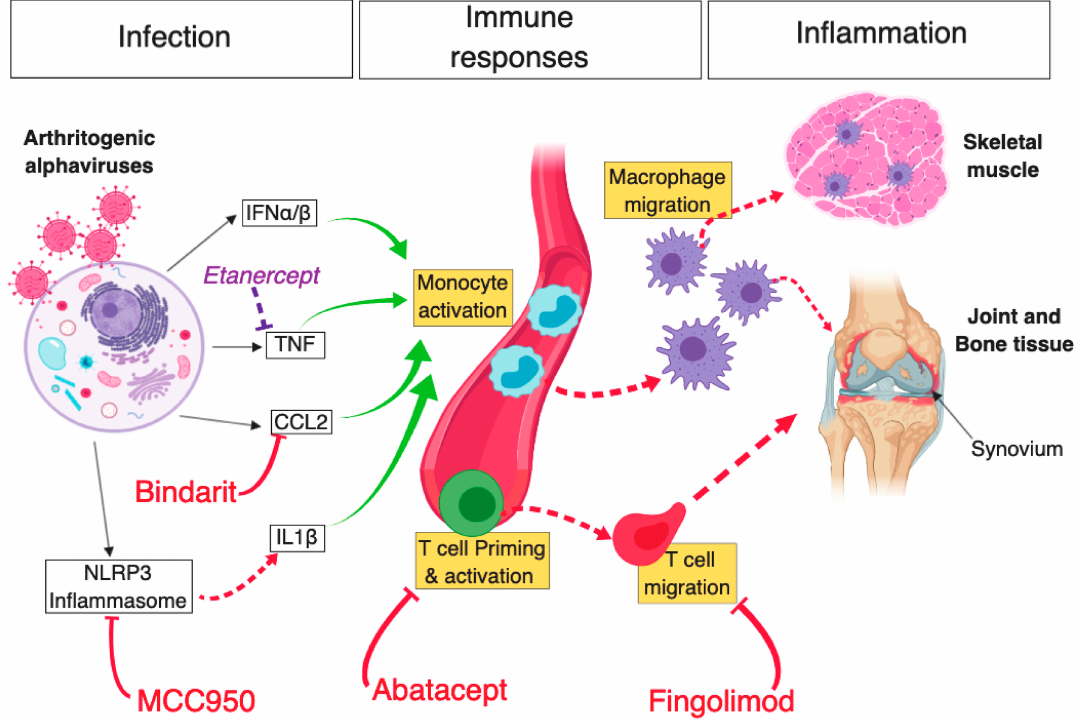
Figure 1. Schematic diagram of key mechanisms of arthritogenic alphavirus-mediated musculoskeletal pathology and novel therapeutic strategies that were shown to limit inflammation and disease. Infection of host mammalian cells by arthritogenic alphaviruses—following a mosquito bite—elicits a potent antiviral cellular response driven by type I IFN, subsequently leading to the production of various proinflammatory cytokines (e.g., CCL2, TNF). In parallel, activation of the NLRP3 inflammasome following alphaviral infection leads to the production of IL-1 β , which further contributes to inflammation. Bindarit, a monocyte-chemotactic protein (MPC) inhibitor with CCL2- neutralising properties, was shown to curtail monocyte activation and subsequent macrophage migration to musculoskeletal tissues. Likewise, inhibition of NLRP3 using MCC950 was found to abrogate inflammasome and caspase-driven IL-1 β production, in turn, reducing muscle inflammation and bone resorption in CHIKV-infected mice. However, inhibition of TNF using Etanercept (commonly used in the treatment of rheumatoid arthritis) exacerbated alphaviral inflammation of muscle and joint tissue. In addition, alphavirus infection leads to the activation of adaptive immune responses and inhibition of CD4 + T cell priming, or egress from draining lymph nodes in CHIKV-infected mice using Abatacept and Fingolimod, respectively, led to a substantial reduction in cellular infiltration in ankle joints. Red T arrows: inhibitory effect leading to positive disease outcome; Dashed red arrows: direct activation; Solid green arrows: cell stimulatory effect; Solid black arrows: antiviral response products; Purple T arrow: inhibitory effect leading to negative disease outcome. Diagram created using BioRender©.